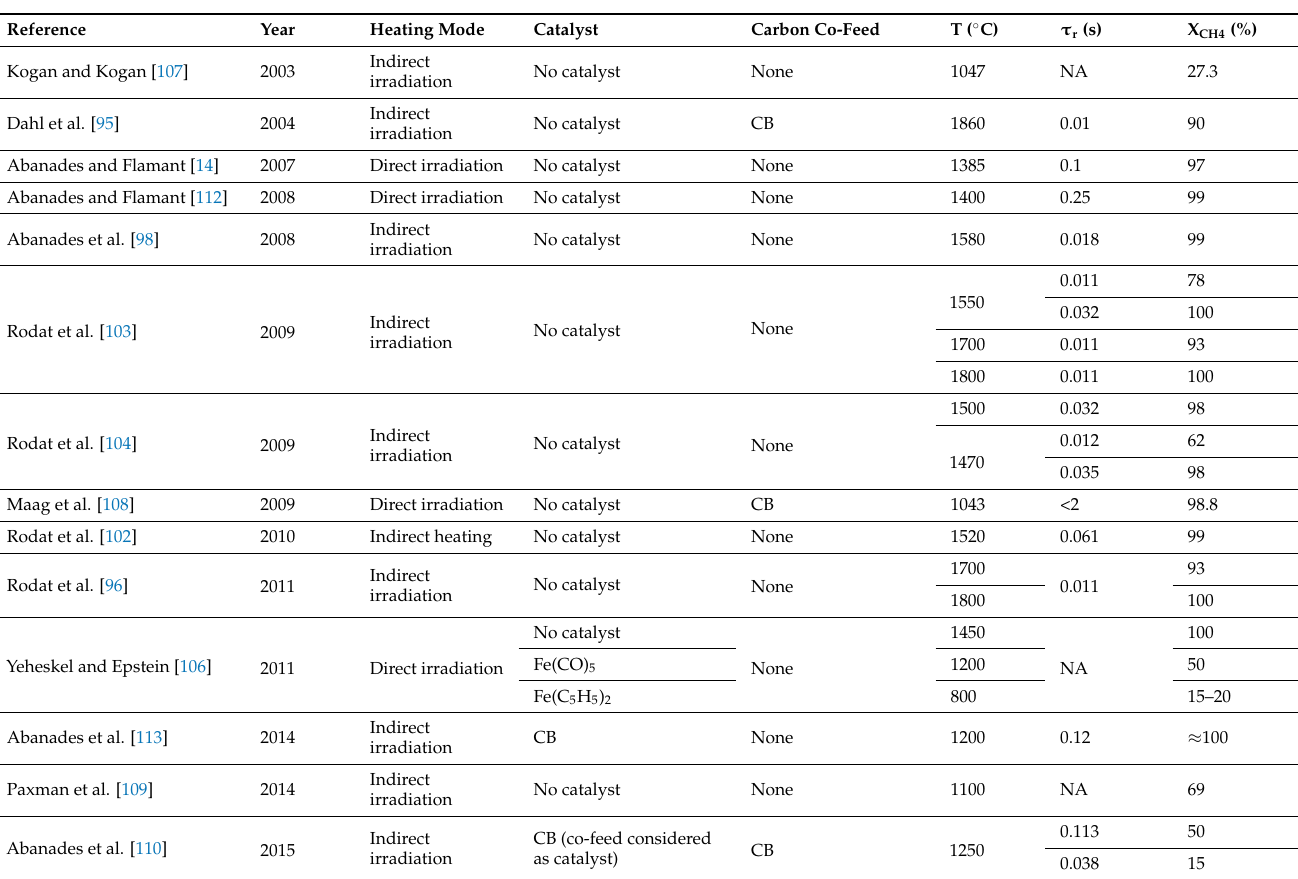
Table 1. Main studies concerning solar methane cracking in gas phase (NA: not